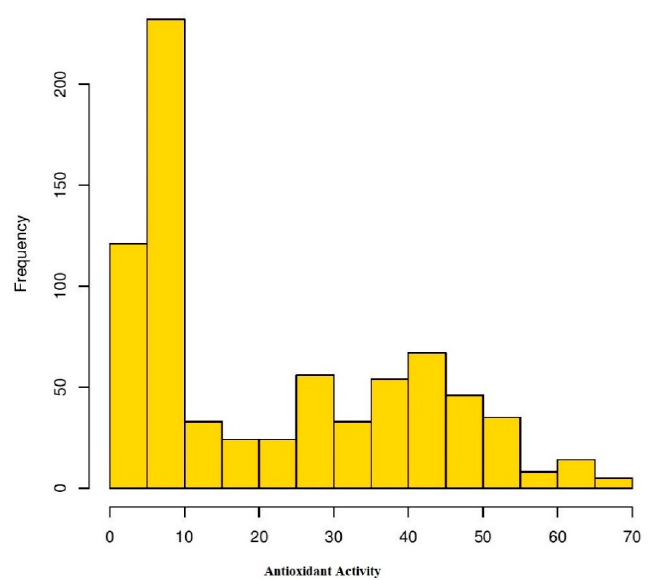
Figure 3. Frequency distribution of antioxidant activity in Turkish common bean germplasm under four environments. Table 2. Pearson’s correlation coefficient between various seeds colors and antioxidant activity .